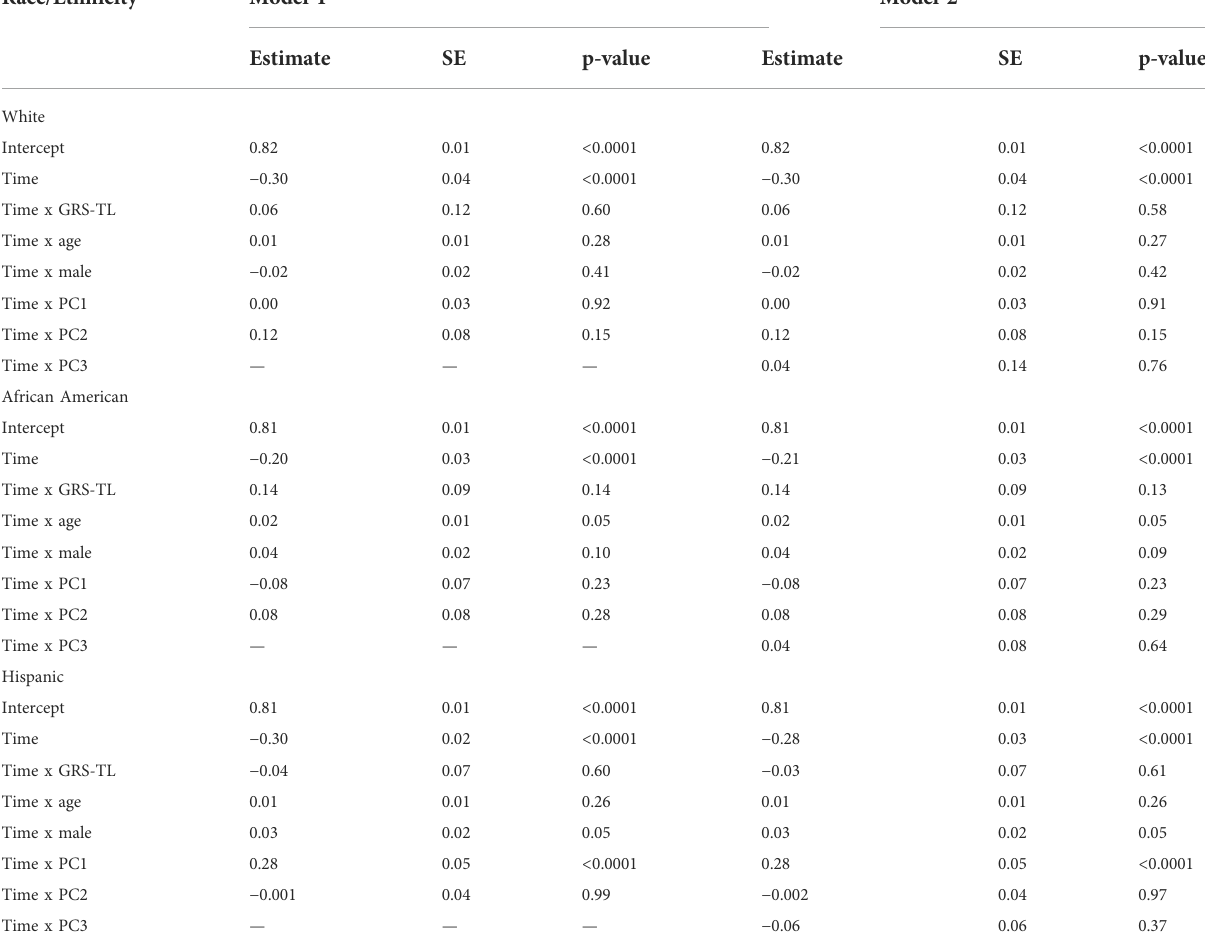
TABLE 5 Analysis of the association of GRS-TL with 10-year Telomere Attrition (10-year TA) strati fi ed by race/ethnicity.